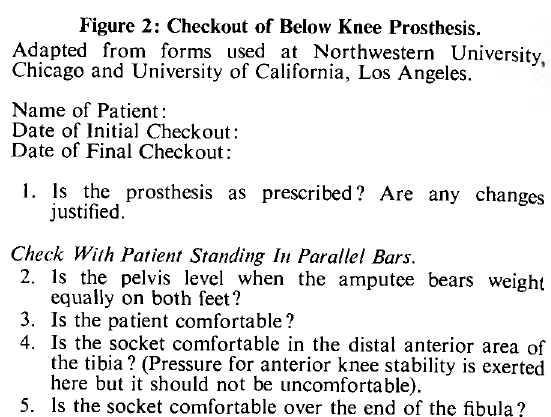
Figure 1: Below Knee Amputee Prosthetic Prescription.